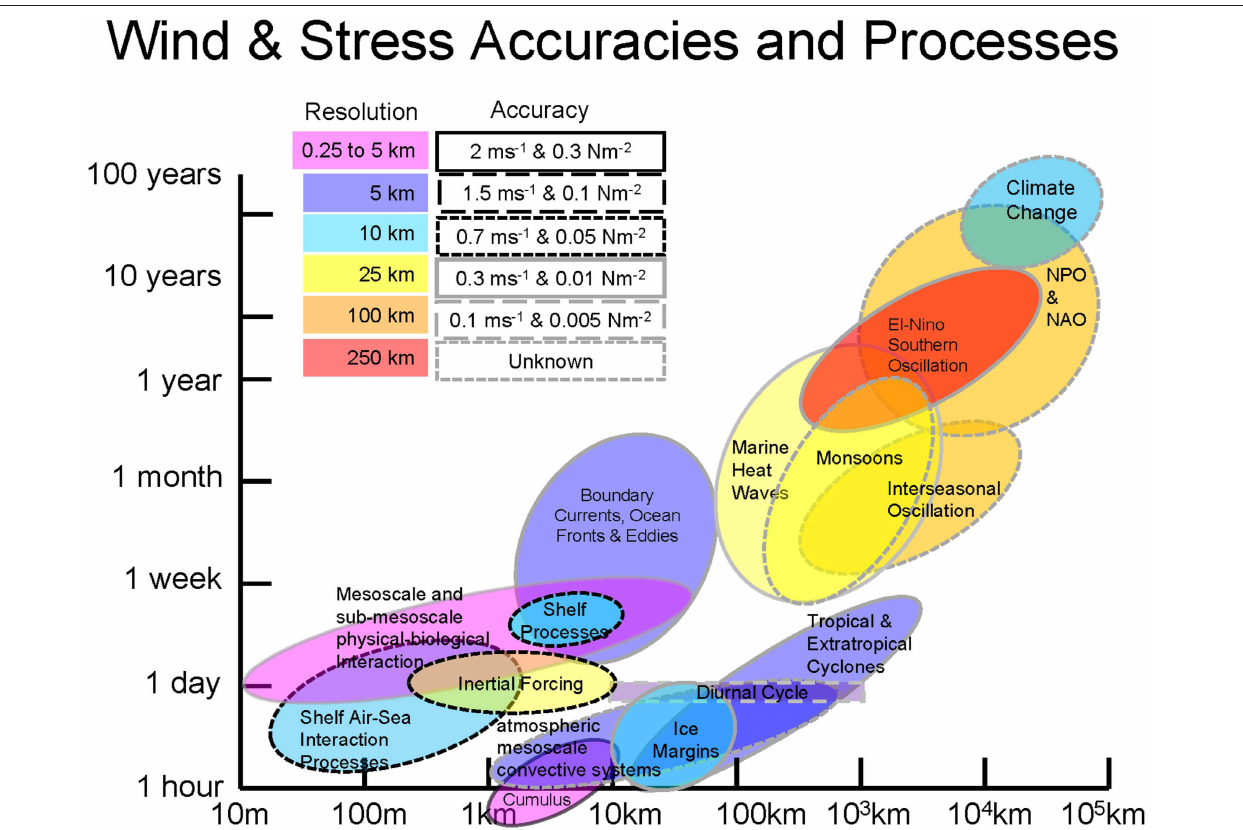
FIGURE 9 | Summary of observing system requirements for accuracy and resolution. For the larger-scale processes ( ≥ 100km), there will be sufficient sampling to reduce random errors to the point where they are a small concern compared to systematic errors in calibration. Currently, both bias and systematic errors are important at 25km and at finer scales random errors will dominate on shorter timescales. Some of the smaller-scale processes (e.g., physical-biological interactions) are influenced more by horizontal shear than by the magnitude of the wind or stress, and therefore have very little sensitivity to systematic errors, but require finer spatial resolution to determine these spatial